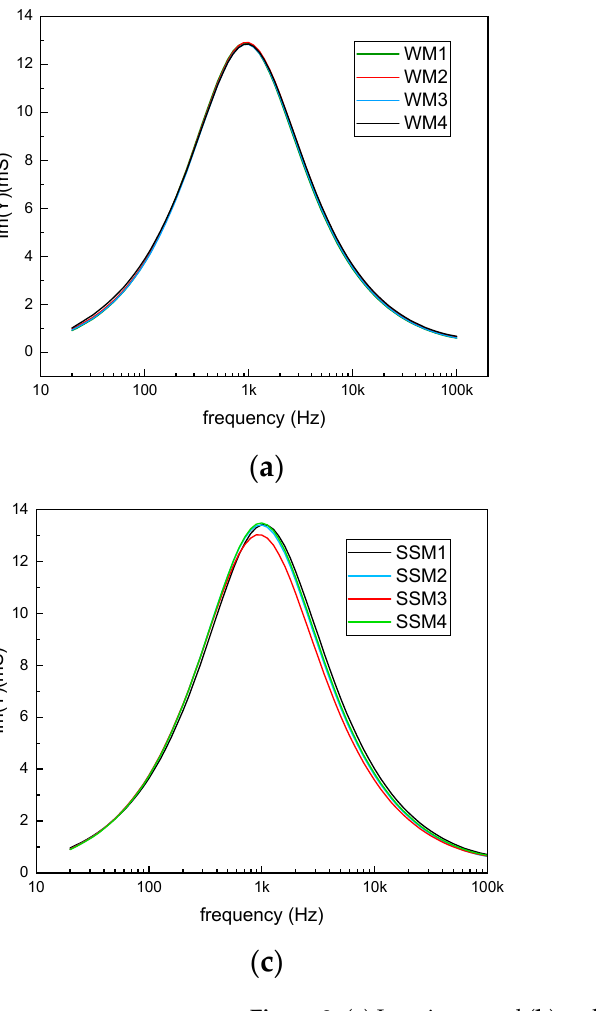
Figure 3. ( a ) Imaginary and ( b ) real parts of the measured admittances for whole milk samples from different brands; ( c ) imaginary and ( d ) real parts of the measured admittances for semi-skimmed milk samples from different brands.